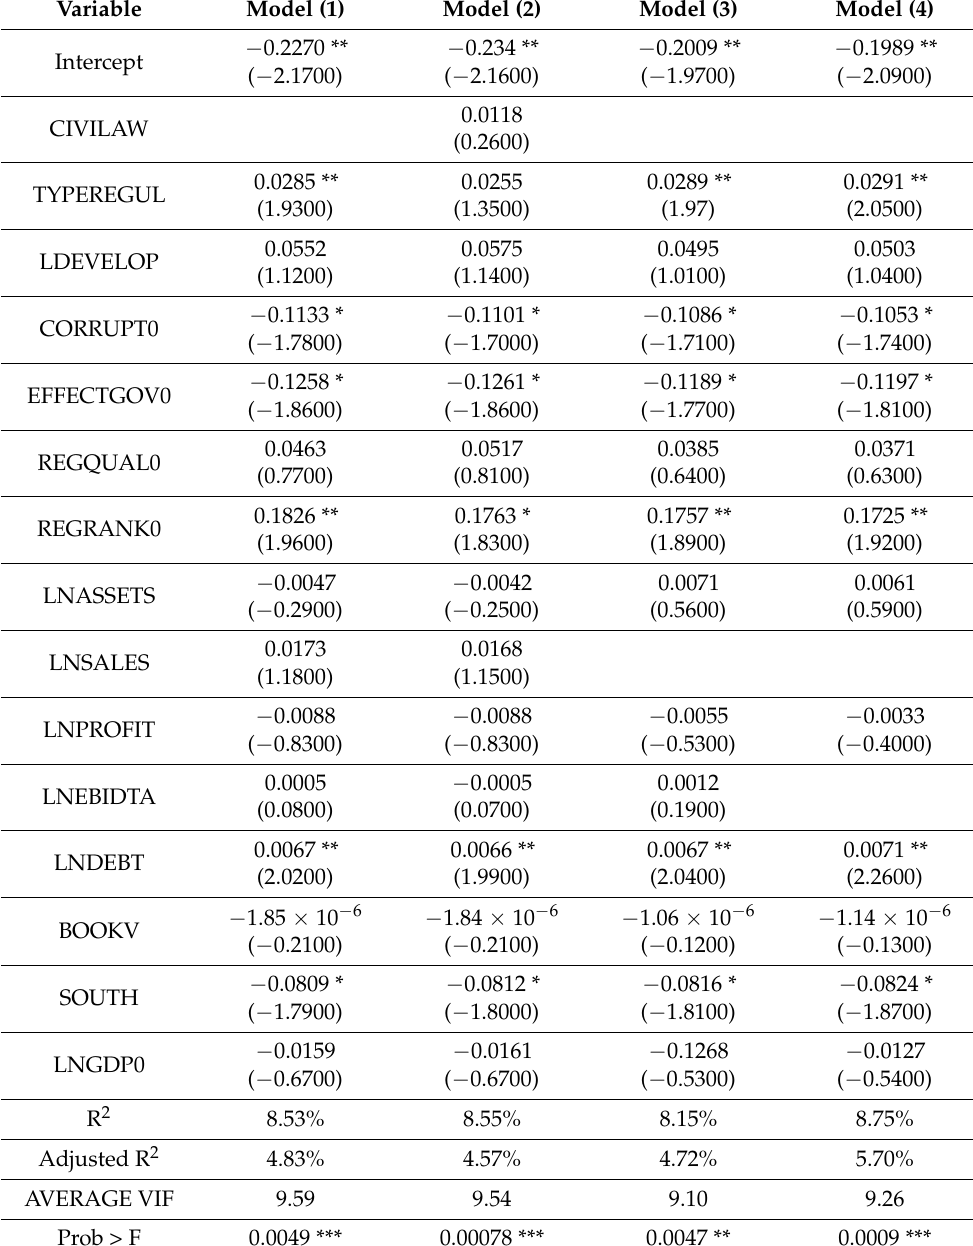
Table 5. Adjusted initial return—LNARI—results